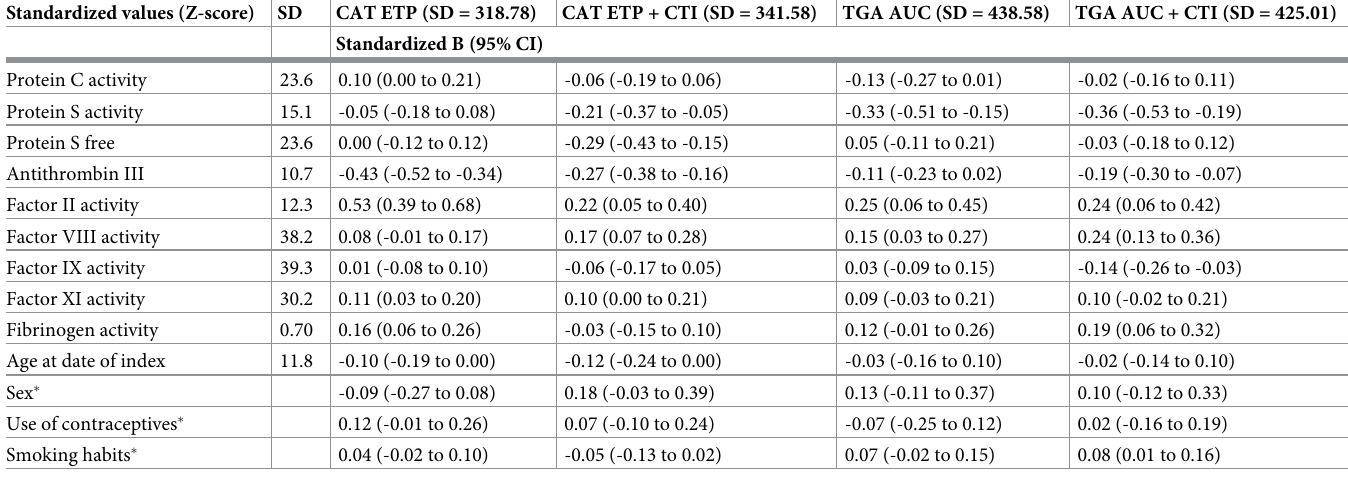
Table 3. Mean change in thrombin generation with 1 standard deviation (SD) increase in coagulation determinants. Standardized values (Z-score) SD